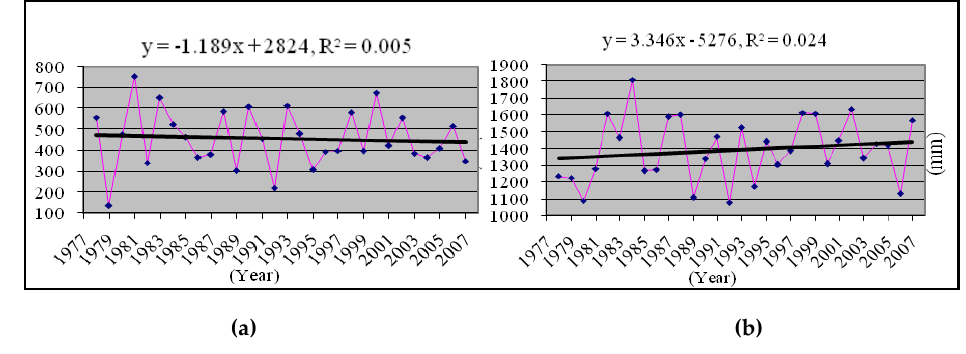
Figure 8. Shows total rainfalls in Bangladesh ( a ) Pre-Monsoon ( b ) Monsoon